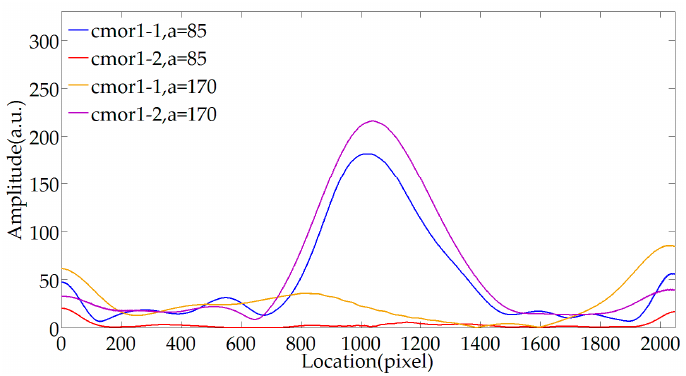
Figure 7. Influence of the center frequency and the scale parameter on envelope extraction.